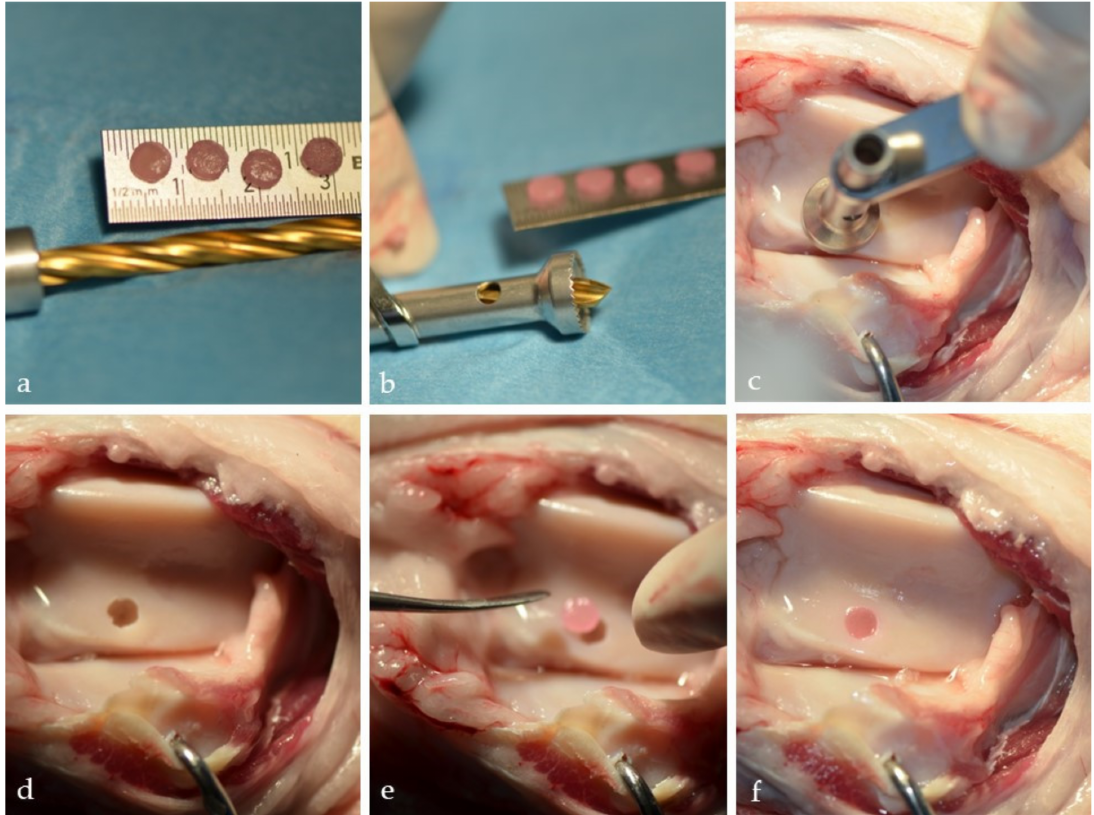
Figure 5. Wet lab mechanical stability testing of the iPSCs-based engineered cartilage construct. ( a ) Cartilage constructs engineered from iPSCs differentiated into chondrocytes. ( b , c ) Special drill was used to create defects on sheep trochlea. ( d ) Full-thickness cartilage defect on sheep trochlea. ( e ) Cartilage construct ready for press-fit transplantation. ( f ) Cartilage construct seated in the defect. Stable, no protrusion beyond the defect borders. (Cartilage constructs were grown and provided by Wa’el Kafienah, University of Bristol,